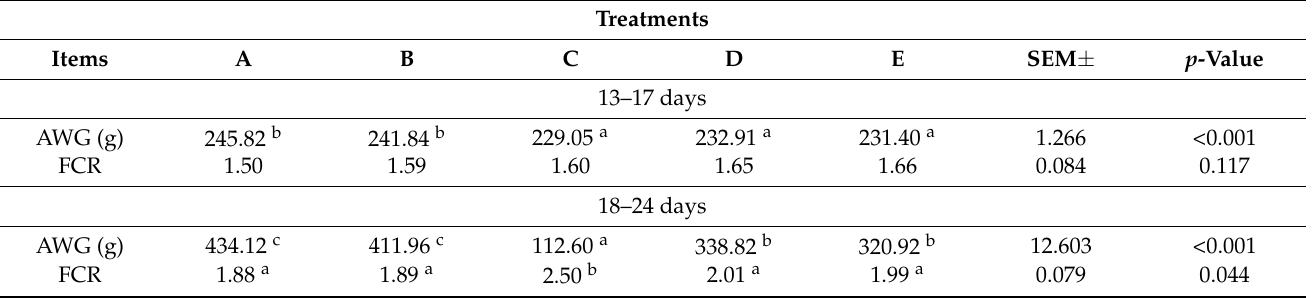
Table 3. Changes in production performance of broilers between different groups during the experiment. Treatments